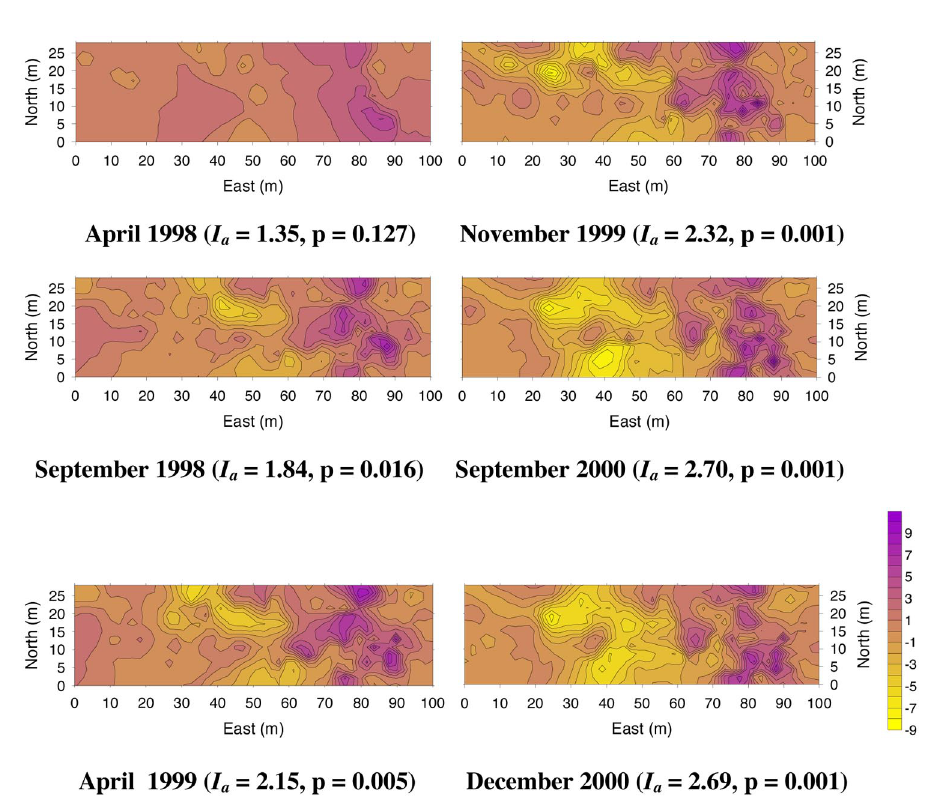
Fig. 6. Maps showing the small-scale spatial pattern of survival (estimated with the SADIE’s index of aggregation, Perry et al. 1999) of 205 randomly-introduced Pistacia lentiscus seedlings in a 100 × 28 m experimental area from SE Spain. The maps show the distribution and evolution of patches (high survival areas, in purple) and gaps (low survival areas, in yellow) during the three years after planting. Values of I (SADIE’s index of aggregation) significantly higher than 1 indicate that the overall spatial pattern of survival in the plot is a aggregated. Adapted from Maestre et al.